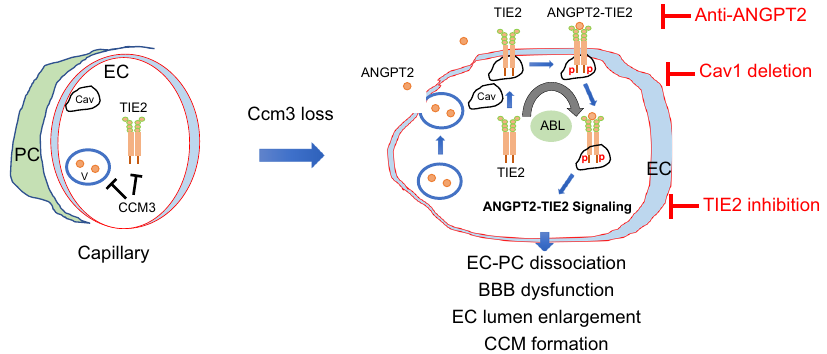
Fig. 10 A model for Caveolae-mediated Tie2 signaling in CCM progression. CCM3 in brain ECs normally suppresses caveolae by yet unknown mechanism. CCM3 loss in ECs causes enhanced caveolae-mediated Tie2 surface expression and endocytosis, leading to EC junctional disruption, EC- pericyte dissociation, BBB dysfunction, and lumen enlargement. Non-receptor kinase Abl cooperatively regulates Tie2 expression and activity. Cav1 de fi ciency or Tie2 inhibition, like neutralization of Angpt2 ligand, ameliorates CCM lesion progression in the mouse CCM models, with normalization of EC- pericyte interaction and vascular